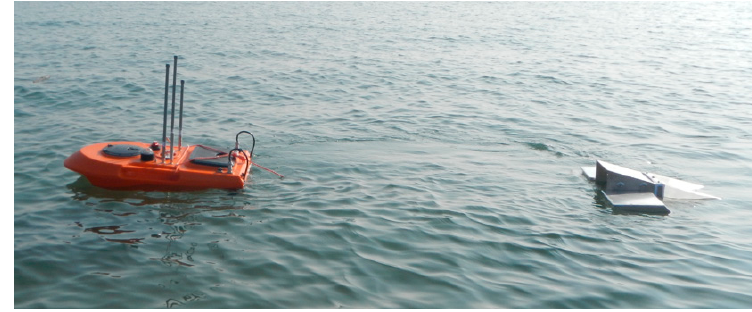
Figure 5. NET4mPLASTIC Lagrangian monitoring node.